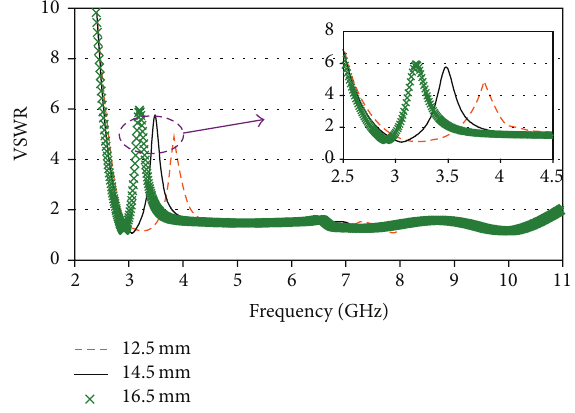
Figure 3: VSWR characteristics for different 𝑥 1 .